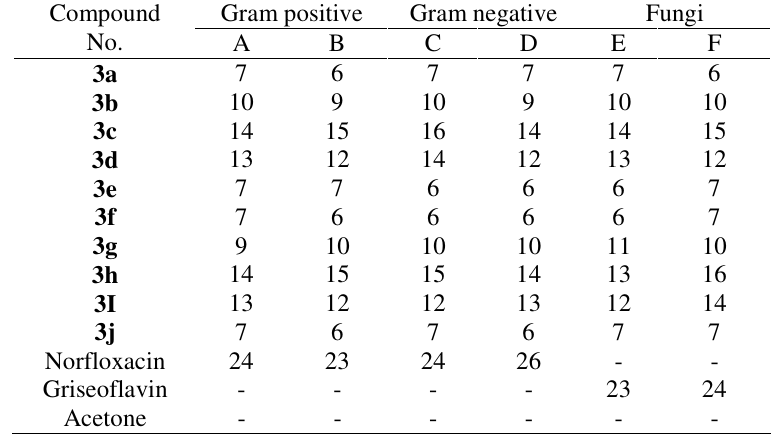
Table 1. Antibacterial activities of compounds 3a-3j (Diameter of the zone of inhibition in